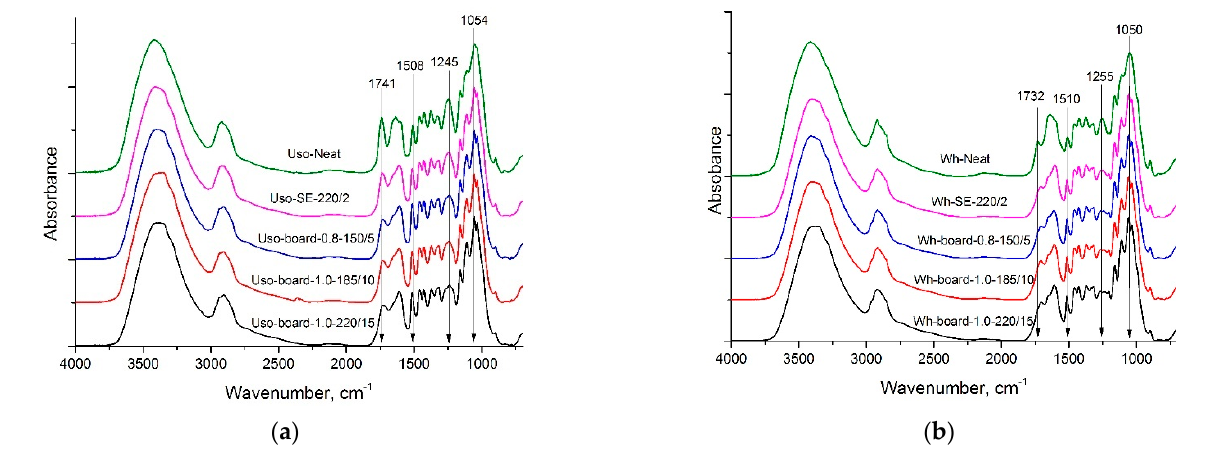
Figure 17. FTIR spectroscopy of neat, pre-treated and board samples from ( a ) Uso hemp shives and ( b ) wheat straw.